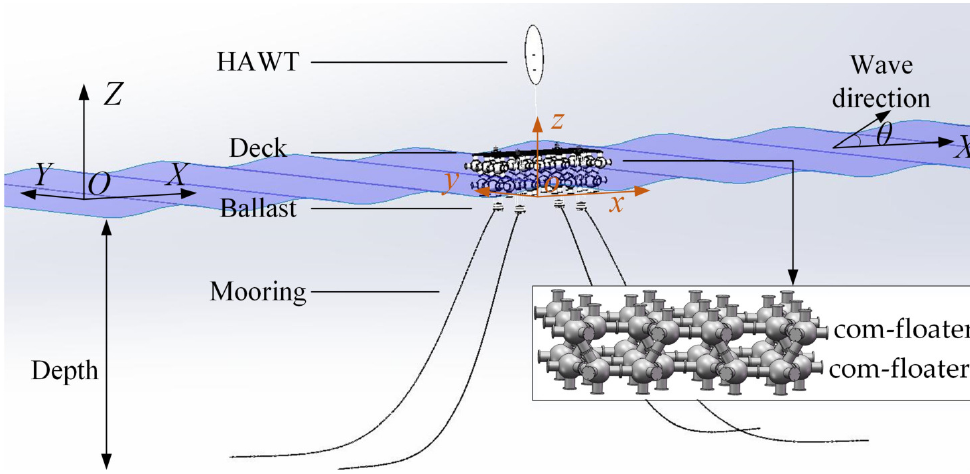
Figure 4. Sketch of the floating system.